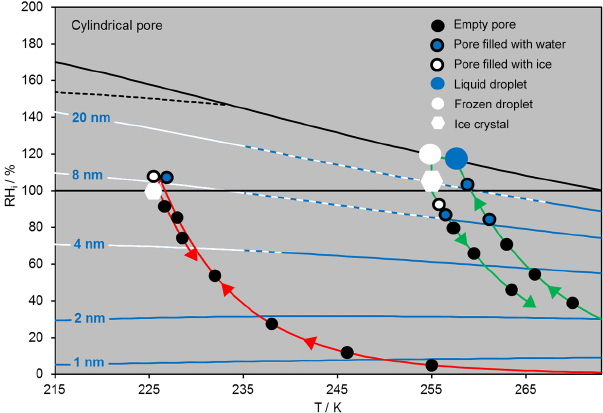
Figure 1. Wet trajectory (green line) and dry trajectory (red line) of a particle with a cylindrical pore of 8nm diameter. Adiabatic cooling, followed by adiabatic heating. The black horizontal line denotes ice saturation; the black sloped line indicates RH i /T con- ditions for water saturation (parameterization of Murphy and Koop, 2005). The black dashed line gives homogeneous ice nucleation ac- cording to Koop and Zobrist (2009). The white/blue lines delimit the onset of pore filling, which was calculated using the inverse Kelvin equation (Eq. 1). Pores with diameters given on the lines are filled at RH i values above the line and are empty below the line. The white portion denotes pore ice, the blue one pore water, and the dashed portion pore water or pore ice, depending on the particle history. The limit to high temperature of the dashed portion marks pore melting. Water in pores of 2 and 1nm remains